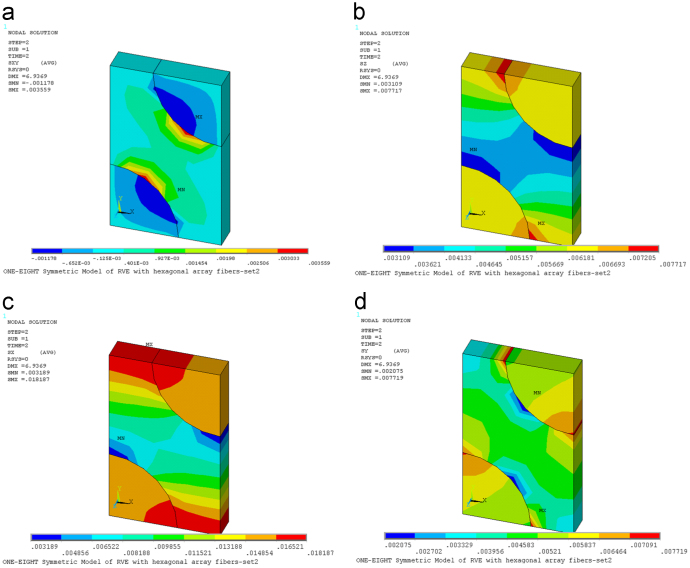
(a) Contour plot of stresses τxy on deformed RVE [TPa]. (b) Contour plot of stresses σz on deformed RVE [TPa]. (c) Contour plot of stresses σx on deformed RVE [TPa]. (d) Contour plot of stresses σy on deformed RVE [TPa].